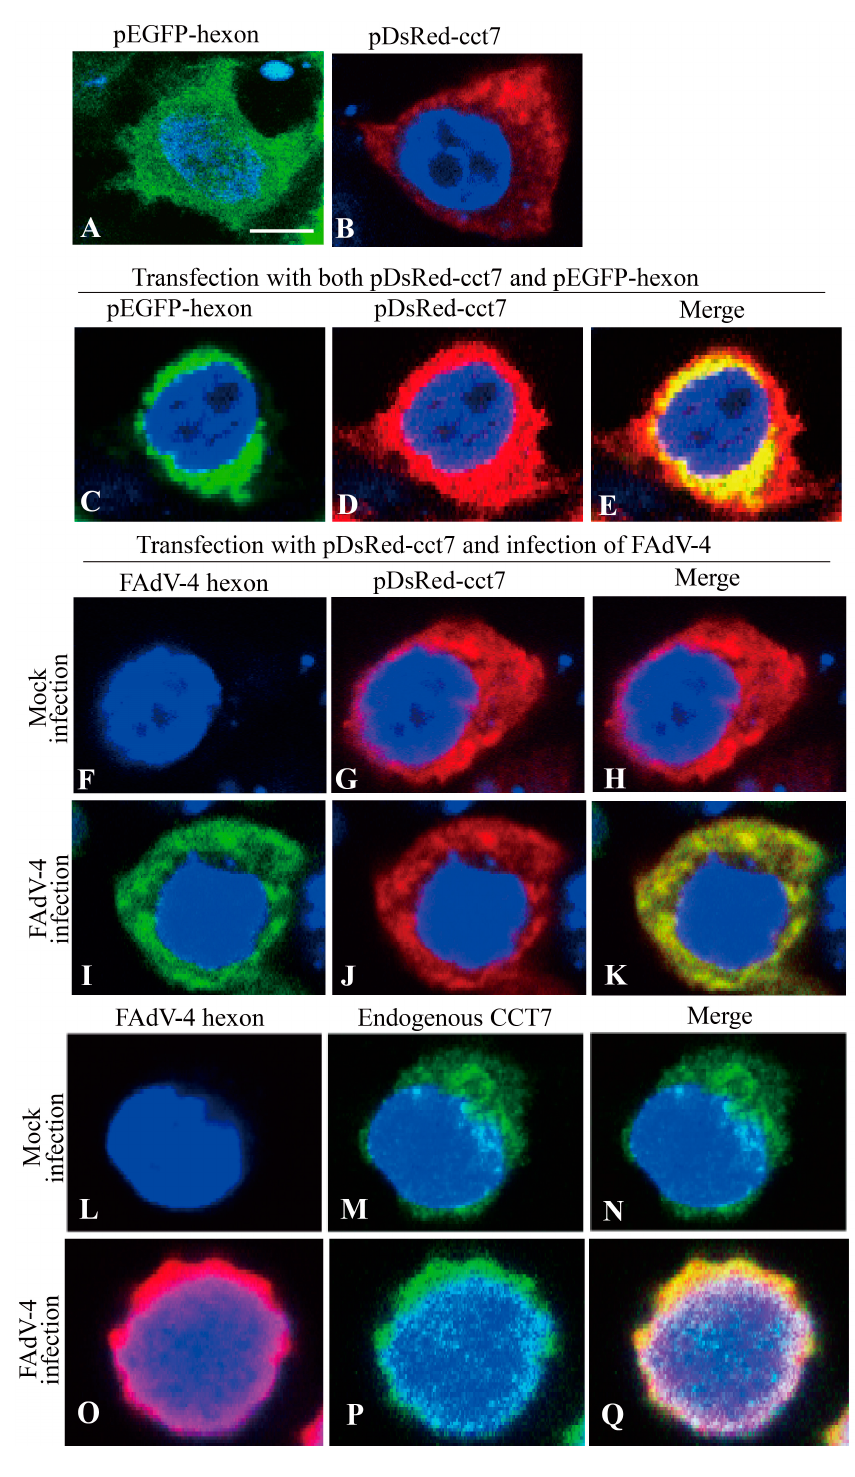
Figure 4. Colocalization of hexon with CCT7 in LMH cells. ( A – E ) Localization of hexon and exogenous CCT7 in LMH cells. LMH cells were seeded onto 24-well plates with coverslips in the wells and cultured overnight. Cells were transfected with pEGFP-hexon ( A ), pDsRed-cct7 ( b ) or both pEGFP-hexon and pDsRed-cct7 ( C – E ). Twenty-four hours after infection, cells were fixed and the cell nuclei were counterstained with DAPI (blue). The cell samples were observed with a confocal laser scanning microscope. ( F – K ) Colocalization of FAdV-4 hexon with exogenous CCT7 in FAdV-4-infected cells. LMH cells were mock infected or infected with FAdV-4 at an MOI of 1. Two hours after infection,